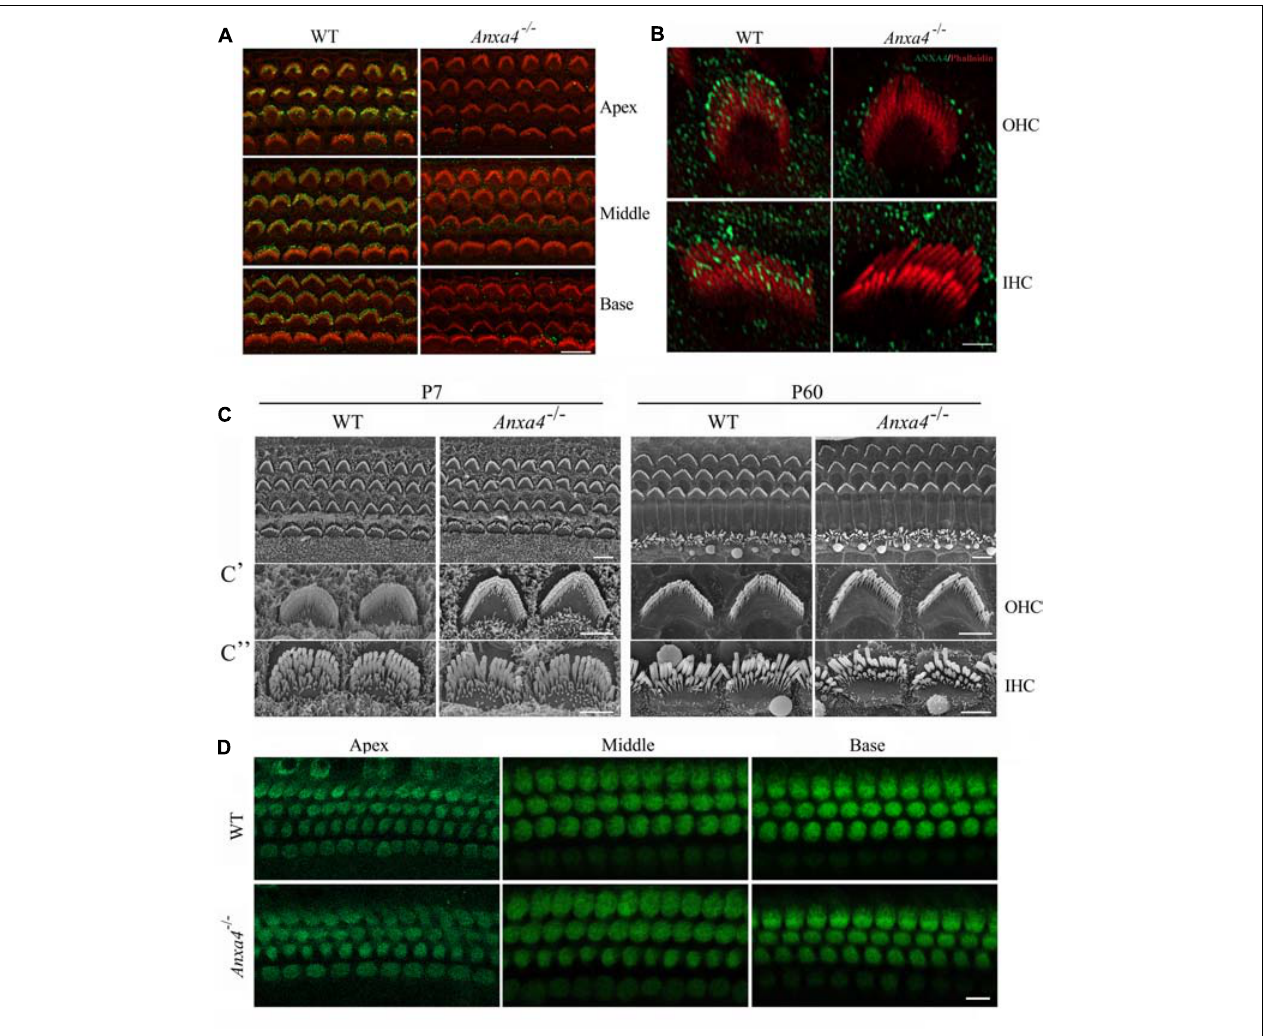
FIGURE 1 | Stereocilia morphology and MET function of cochlear hair cells are unaffected in Anxa4 − / − mice. (A) Cochlear hair cell stereocilia of P5 wild type or Anxa4 − / − mice were stained with anti-ANXA4 antibody (ABclonal) and imaged using confocal microscope. Stereocilia F-actin core was visualized by staining with TRITC-conjugated phalloidin. (B) Higher resolution confocal microscopy images show stereociliary tip localization of ANXA4 in P7 OHC and IHC. (C) Examination of hair bundle morphology of wild type or Anxa4 − / − mice at P7 or P60 using SEM. (C’,C”) Higher resolution SEM images of OHCs and IHCs, respectively. (D) FM1-43FX uptake by OHCs and IHCs of P7 wild type or Anxa4 − / − mice was examined using confocal microscope. Shown are images taken from the middle turn unless otherwise indicated. Scale bars, 10 µ m in (A,D) , 2 µ m in (B , C’,C”) , 5 µ m in (C)